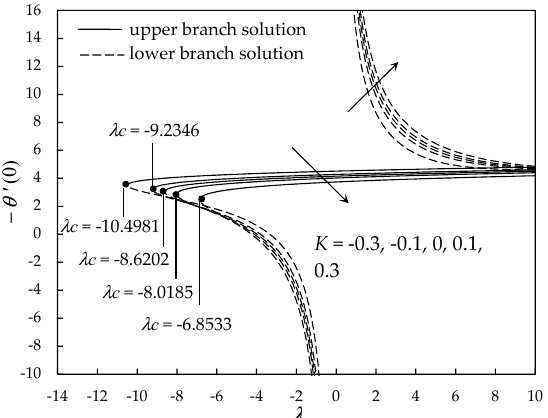
Figure 7. Variation of the reduced local Nusselt number −𝜃′(0) with the mixed convection parameter λ for various values of the heat source/sink parameter K when φ = 0.01, Nr = 0.1, s = 1 and c = − 1 for Cu-water nanofluid.